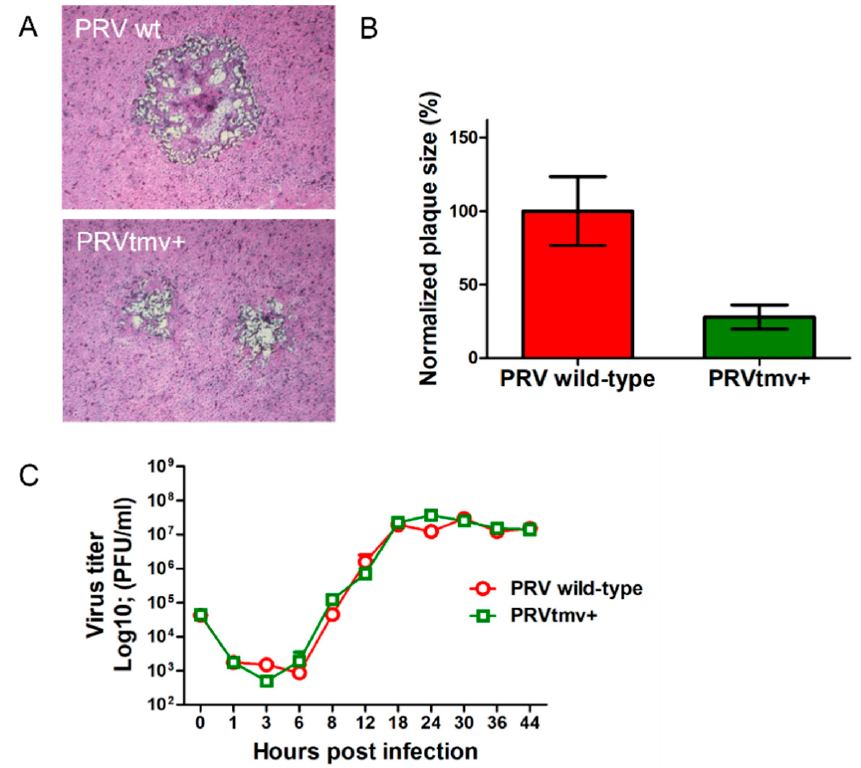
Figure 7. In vitro characterization of PRVtmv+. ( A ) Plaque size analysis of PRVtmv+ compared to that of PRV wt. Shown are the pictures of areas containing representative plaques of each virus. ( B ) Bar graph showing normalized average plaque size ( n = 150) for each virus with standard deviation (SD). ( C ) One-step growth analysis of PRVtmv+ compared with PRV wt. 3.3. PRVtmv+ Vaccine Virus Is Highly Attenuated, Safe, and Retains Its Stability in Pigs to Ex ‐